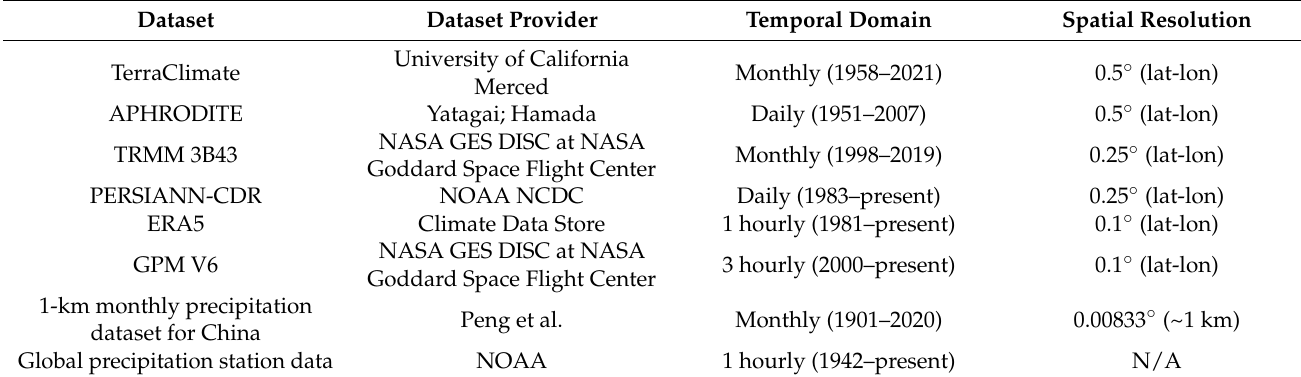
Table 3. Current popular used rainfall datasets.